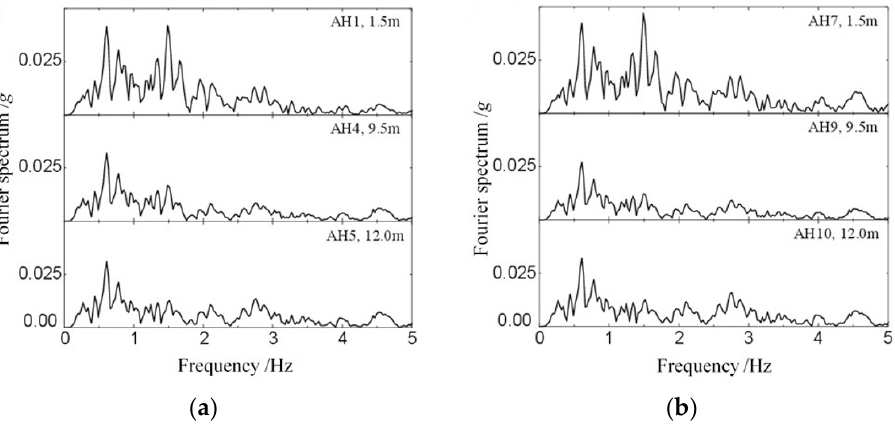
Figure 10. Acceleration Fourier spectrum: ( a ) in the structure; ( b ) in the model soil.